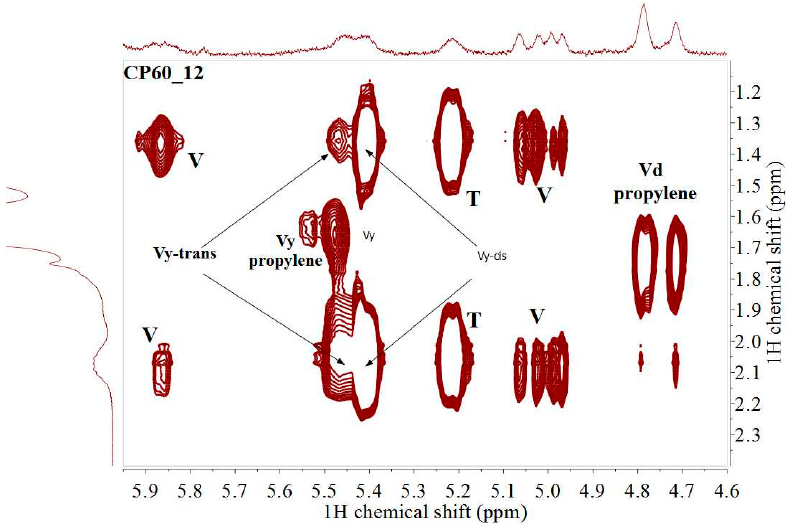
Figure 9. 1 H- 1 H TOCSY map of the sample C9PP60_12.